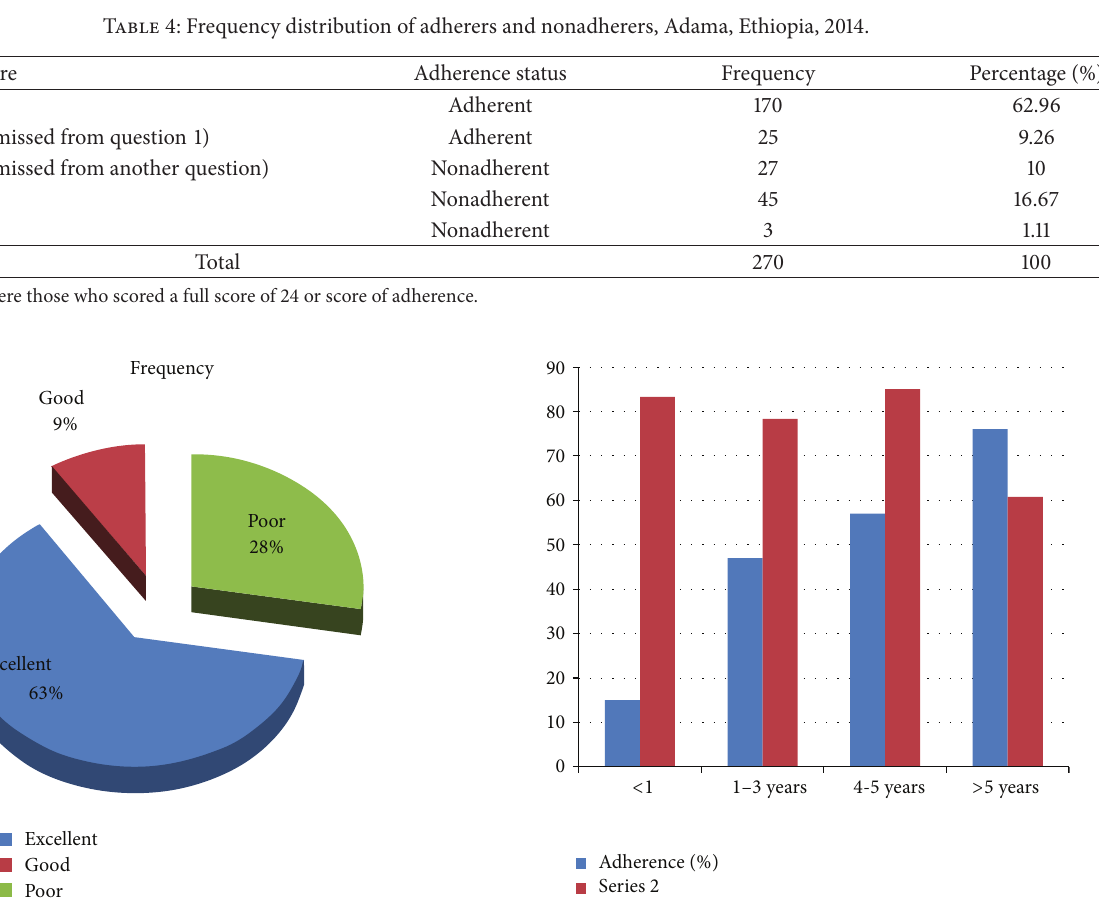
Figure 2: Pattern of adherence, Adama, Ethiopia, 2014. Figure 3: The association between durations of DM adherence, Adama, Ethiopia, 2014 ( 𝑃 = 0.003